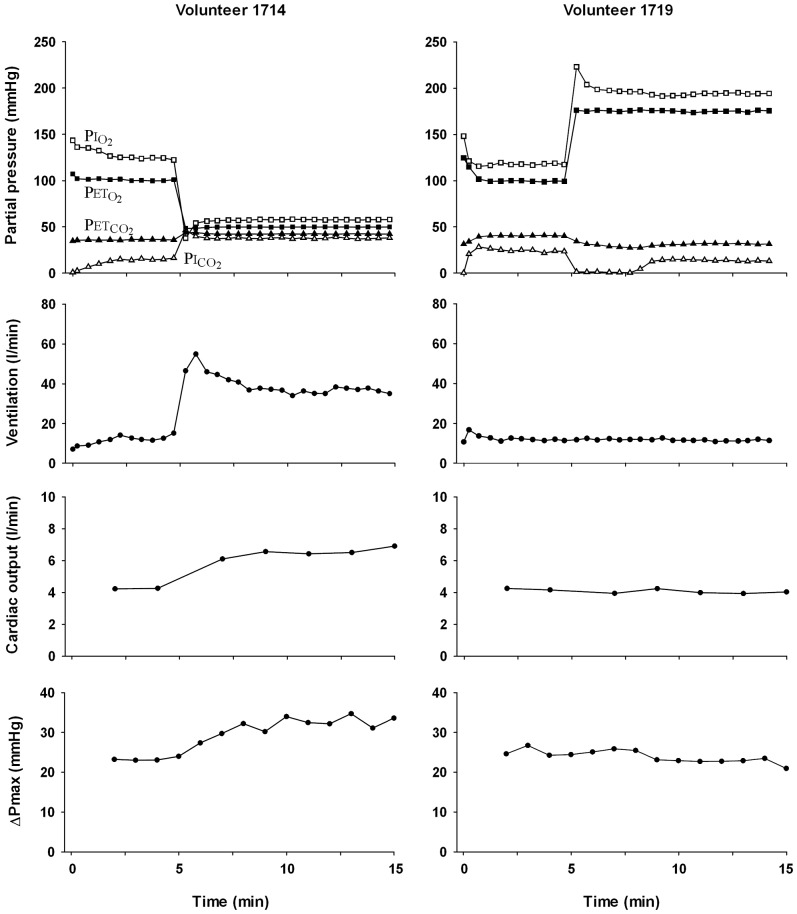
Example data from two protocols on different volunteers.In each protocol the end-tidal gases were held at normal euoxic and eucapnic values for the baseline period of 5 min and then stepped to individual target protocol values. These were as follows: left panels: volunteer 1714 with hypercapnia (Petco
2 = baseline+6 mmHg) and hypoxia (Peto
2 = 50 mmHg) using spontaneous hyperventilation; right panels: volunteer 1719 with hypocapnia (Petco
2 = baseline−9 mmHg) and hyperoxia (Peto
2 = 175 mmHg) using voluntarily controlled constant hyperventilation. Upper panels: inspired oxygen (Pio
2) and carbon dioxide (Pico
2) partial pressures and end-tidal oxygen (Peto
2) and carbon dioxide (Peto
2) partial pressures. Middle panels: ventilation and cardiac output. Lower panels: ΔPmax. Respiratory data represent means of multiple measurements (one per breath) in each time period.